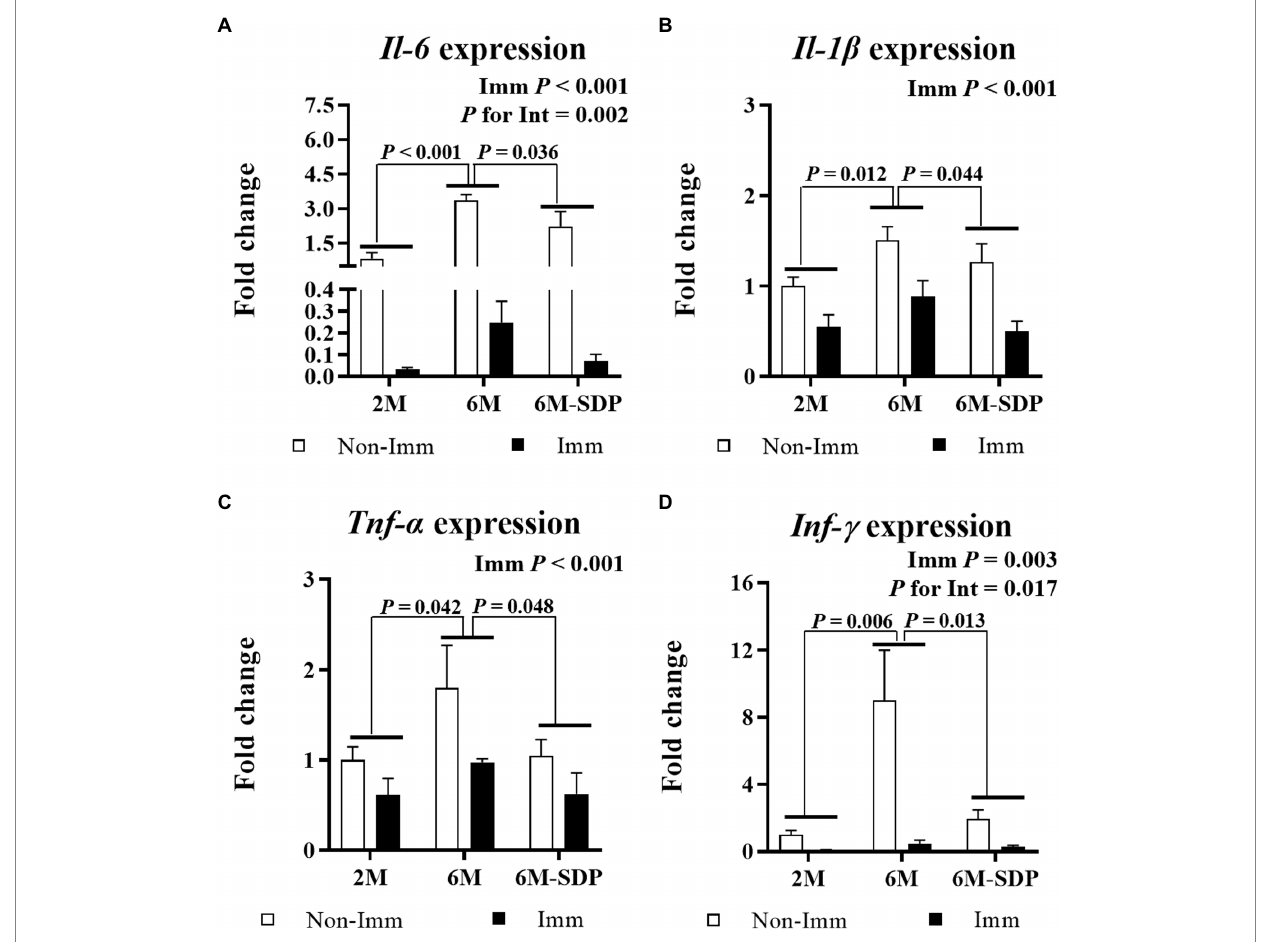
FIGURE 7 mRNA expression of Il-6 (A) , Il-1 β (B) , Tnf- α (C) , and Ifn- γ (D) in the jejunal mucosa. Open bars represent non-immunized ( Non-Imm ) mice; solid bars represent immunized ( Imm ) mice. All target genes were normalized to Gus β expression. The fold-change expression is against immunized 2 M mice. Results are expressed as means ± SEMs ( n = 9–10 animals). Statistics: two-way ANOVA (age-feed and immunization factors; Fisher multiple comparison test). Int indicates the interaction between immunization and age-feed factors. Gus β , glucuronidase beta; Ifn- γ , interferon gamma; Il, interleukin; SDP, spray-dried porcine plasma; Tnf- α , tumor necrosis factor